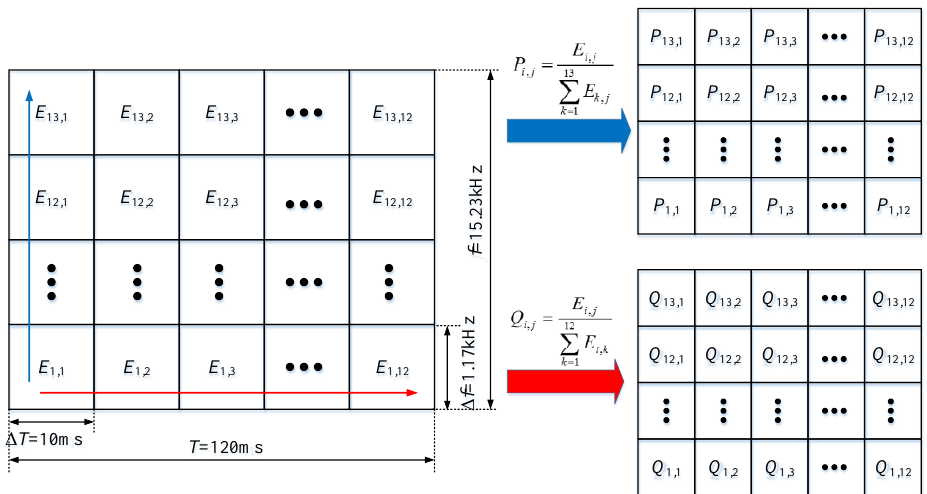
Figure 4. Calculation of wavelet packet time-frequency feature of vibration signal.